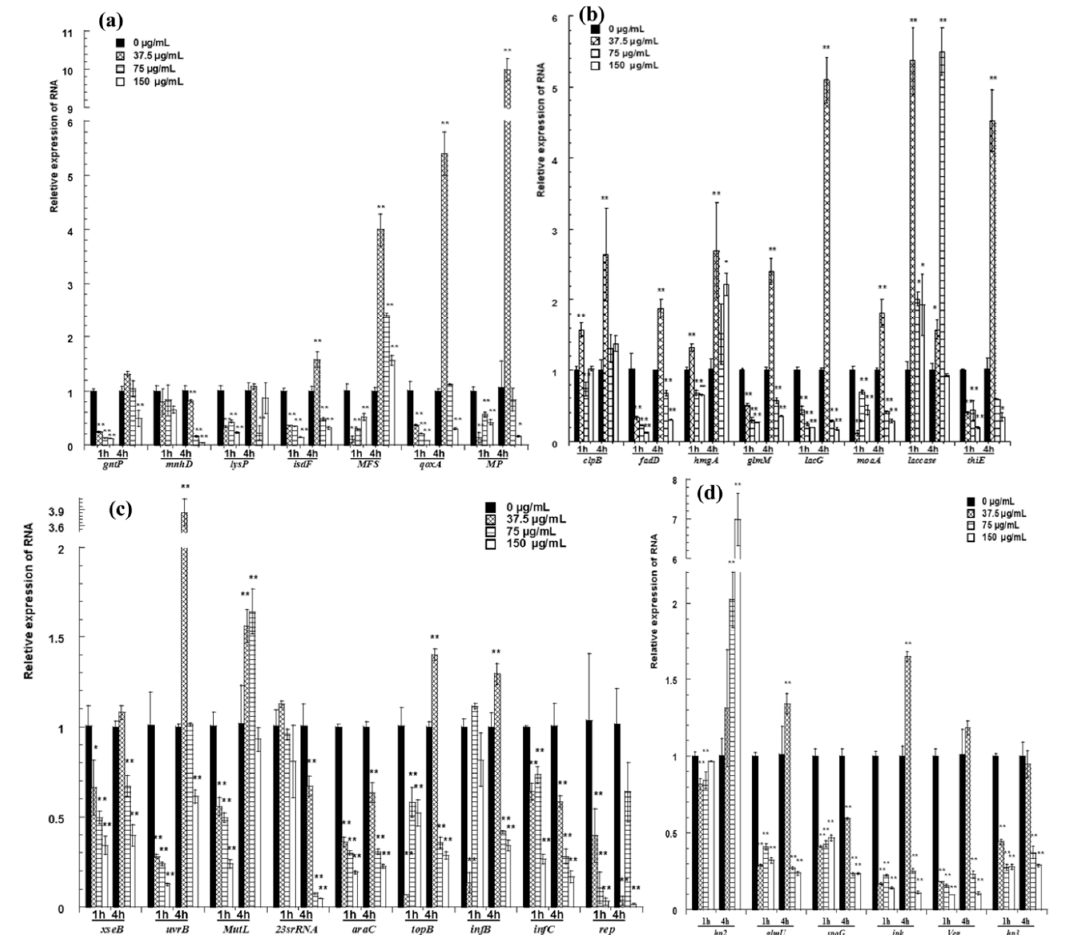
Figure 5. qRT-PCR confirmation for selected genes. ( a ) The relative expression of genes for transport; ( b ) the expression of genes related to metabolism; ( c ) the relative expression of genes related to transport of inheritable information; ( d ) the relative expression of hypothetical proteins and the genes next to two differentially expressed intergenic fragments. The changes in gene expression were calculated by the 2 − △△ CT method with GAPDH as a reference gene. The * and ** symbols at the top of the column indicate significant differences from the control at p < 0.05 and p < 0.01, respectively.